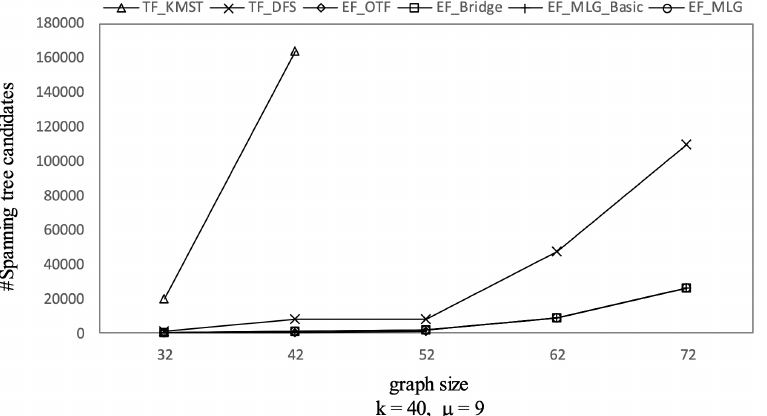
Figure 10. Spanning tree pruning on GraphGen vs. graph size with k = 40 and µ =